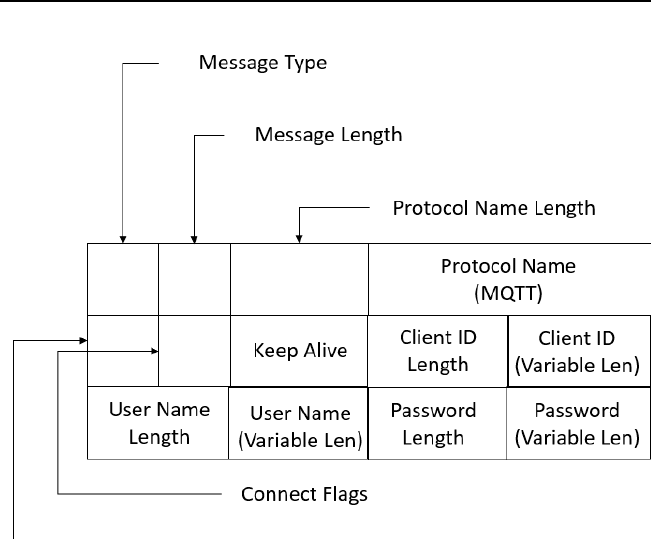
Figure 3. Connect packet structure.